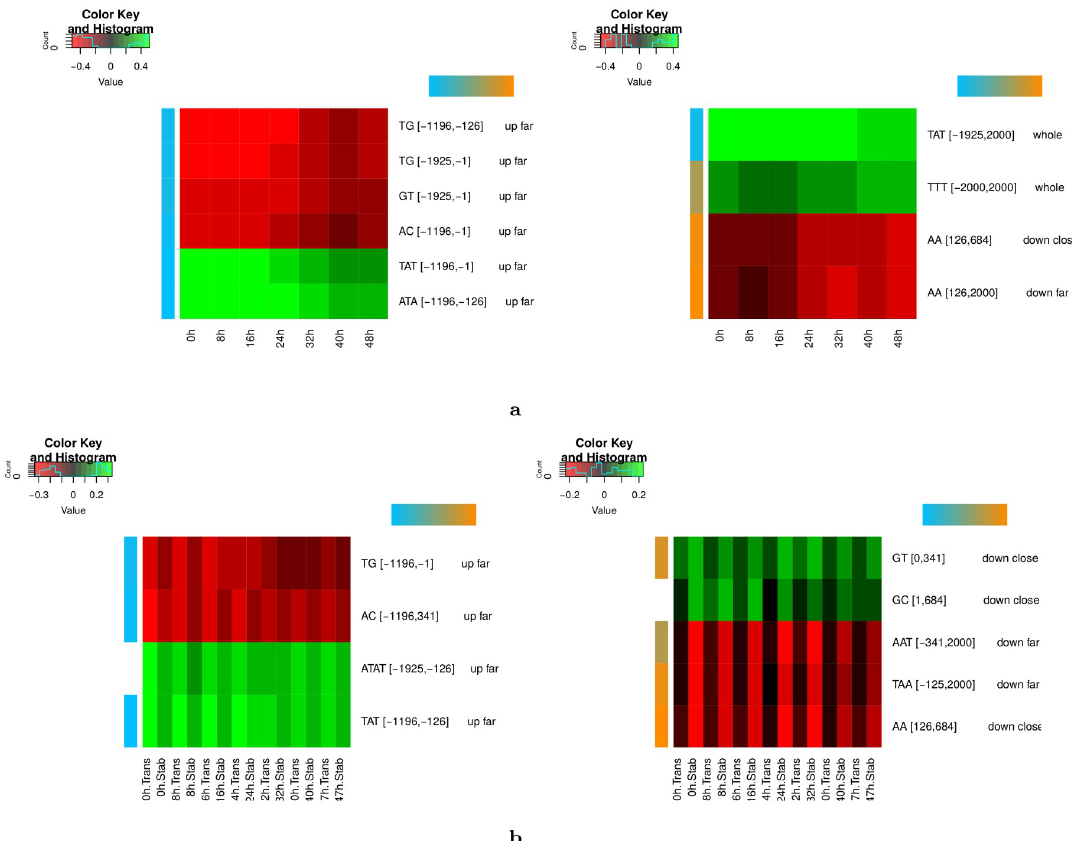
Fig 8. Strand specificity of cLREs and links with post-transcriptional signals in P . falciparum intraerythrocytic cycle. a Heatmaps of correlations between gene expression and most important features identified at each time point of Otto et al. (2010) data. The left heatmap corresponds to features with higher correlation in early time points (0h—16h), while the right heatmap corresponds to features with higher correlation with late time points (24h—48h). The strand specificity of each variable is represented with a color code that goes from blue (no strand specificity) to orange (high strand specificity). b Heatmaps of correlations between gene expression and most important features identified at each time point of Painter et al. (2018) data. The left heatmap corresponds to features with higher correlation with transcription data, while the right heatmap corresponds to features with higher correlation with stabilization data.